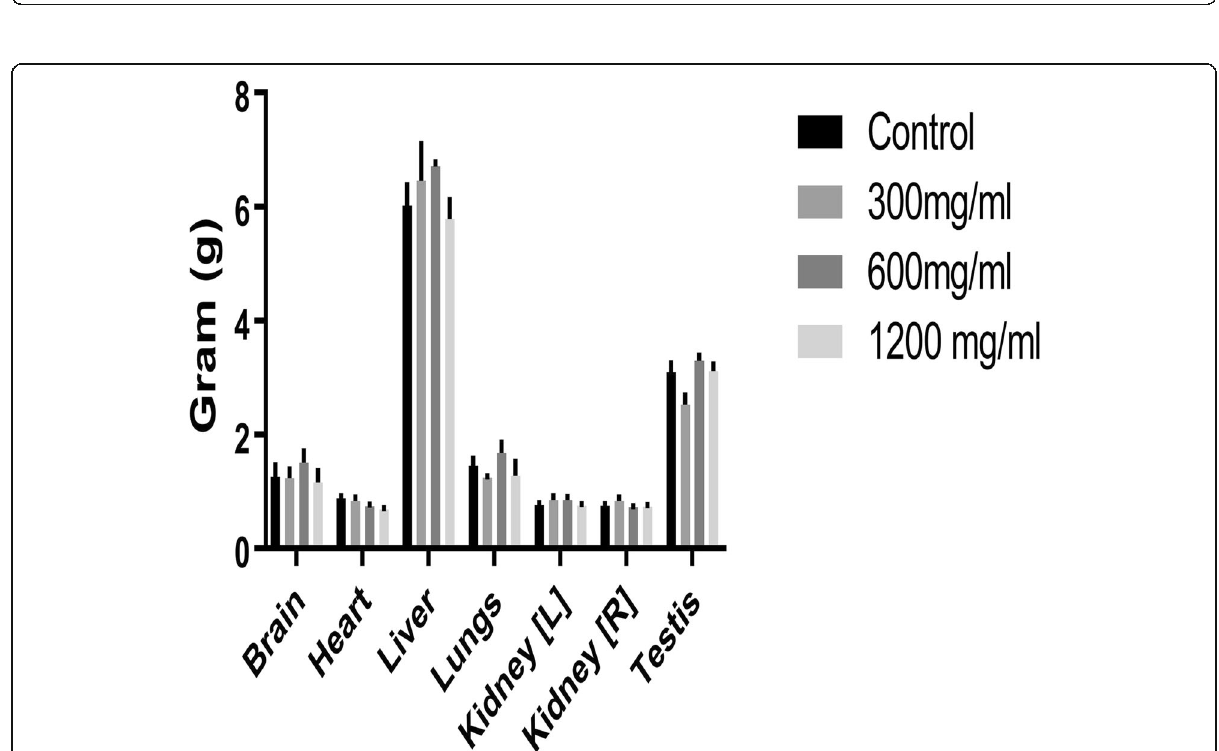
Fig. 3 Effect of STRE on organ weight of male subjects. Values are expressed as mean ± SEM Statistical significance (p) calculated by one way ANOVA followed by dunnett ’ s ( n =